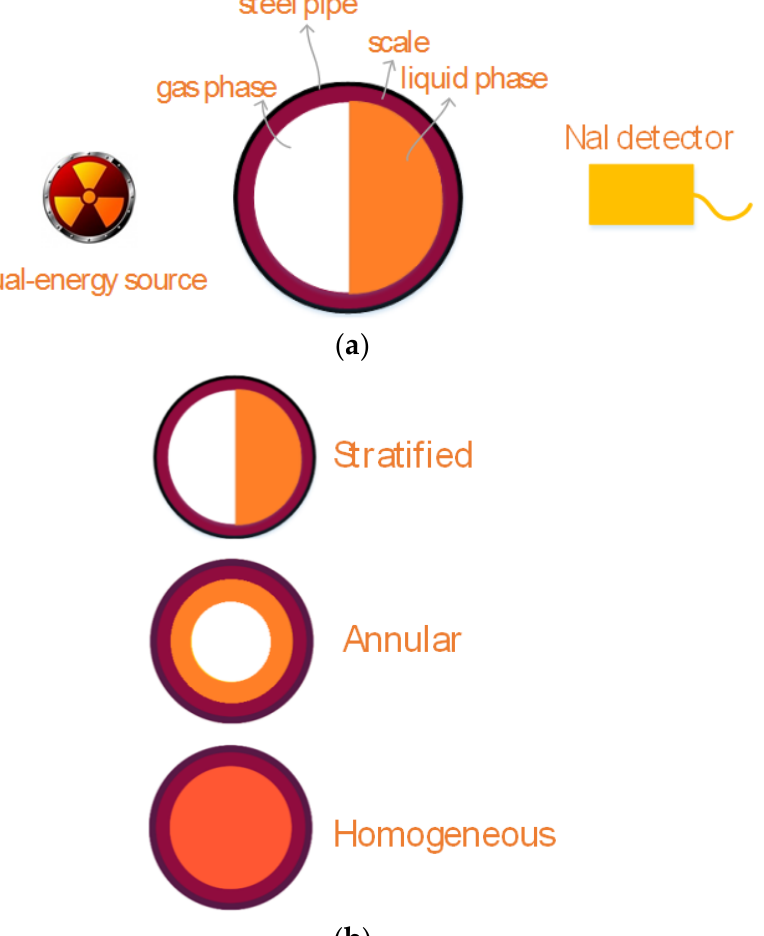
Figure 2. ( a ) Structure of proposed configurations discussed in the study, ( b ) simulated flow